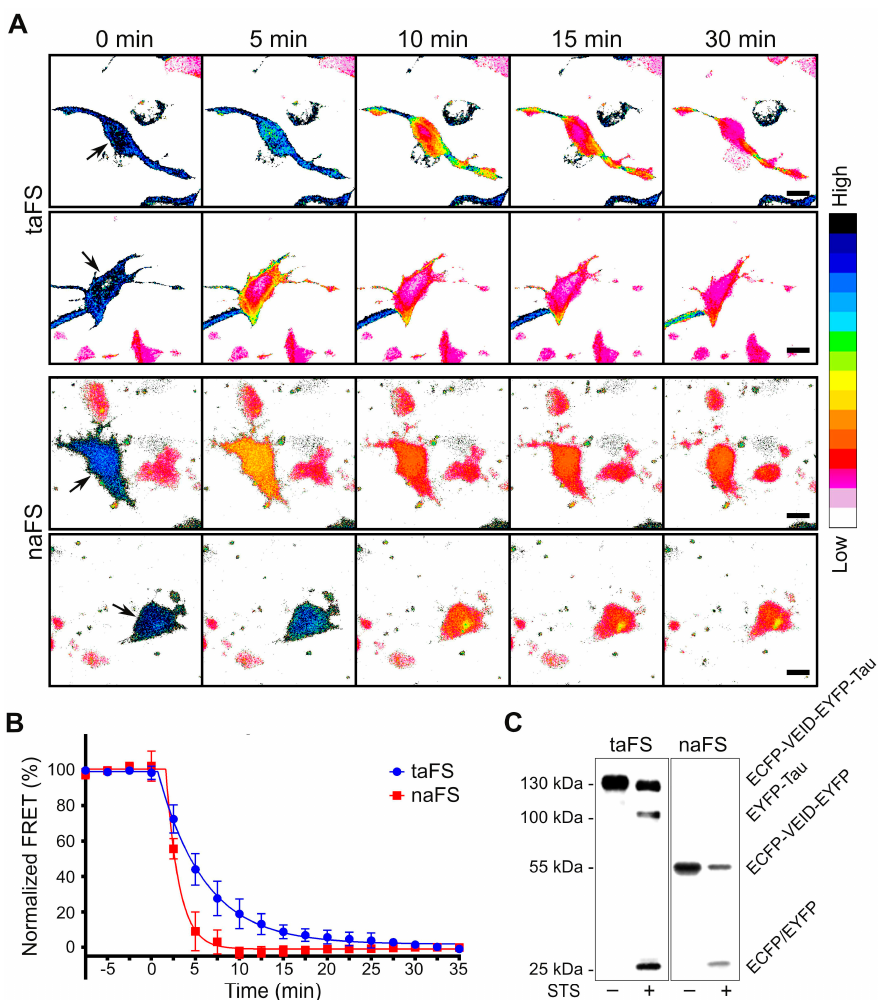
Figure 2. Anchored FRET sensors for detection of active caspases at subcellular level. ( A ) Representative ratiometric (FRET/ECFP) time-lapse images of SK-N-AS cells transfected with taFS-VEID (upper panel) or naFS-VEID (lower panel) and treated with 1 µ M staurosporine. Note the local differences in FRET within the cells expressing taFS-VEID. The early decline in FRET in the central parts of the taFS-VEID-expressing cells is likely reflecting liberation of ECFP from the anchorage and its resulting ability to diffuse. Scale bar 10 µ m. The video montage of the time lapse images is available as Supplementary materials; ( B ) Average of temporally aligned ratio values of the fraction of pixels from each cell retaining the highest FRET (10th percentile) is plotted over time ( n = 8 for taFS and n = 5 for naFS); ( C ) Apoptotic stimuli induce specific fragmentation of anchored (taFS) and non-anchored (naFS) FRET sensors. Human neuroblastoma SK-N-AS cells overexpressing either of the sensors were treated with 1 µ M staurosporine (STS) for 3 h. Total cell lysates were analyzed by western blot with anti-GFP